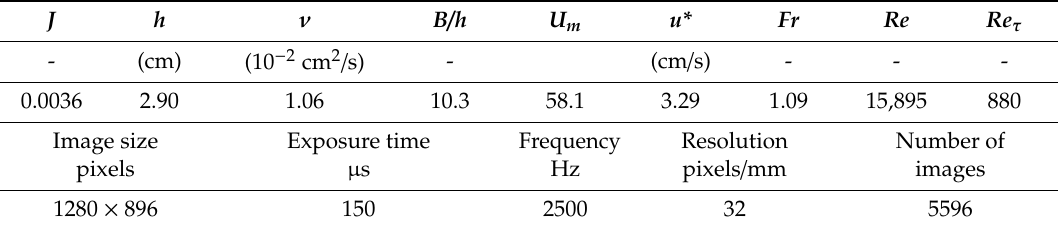
Table 1. Flow condition and particle imaging velocimetry (PIV) parameters. J h ν B /